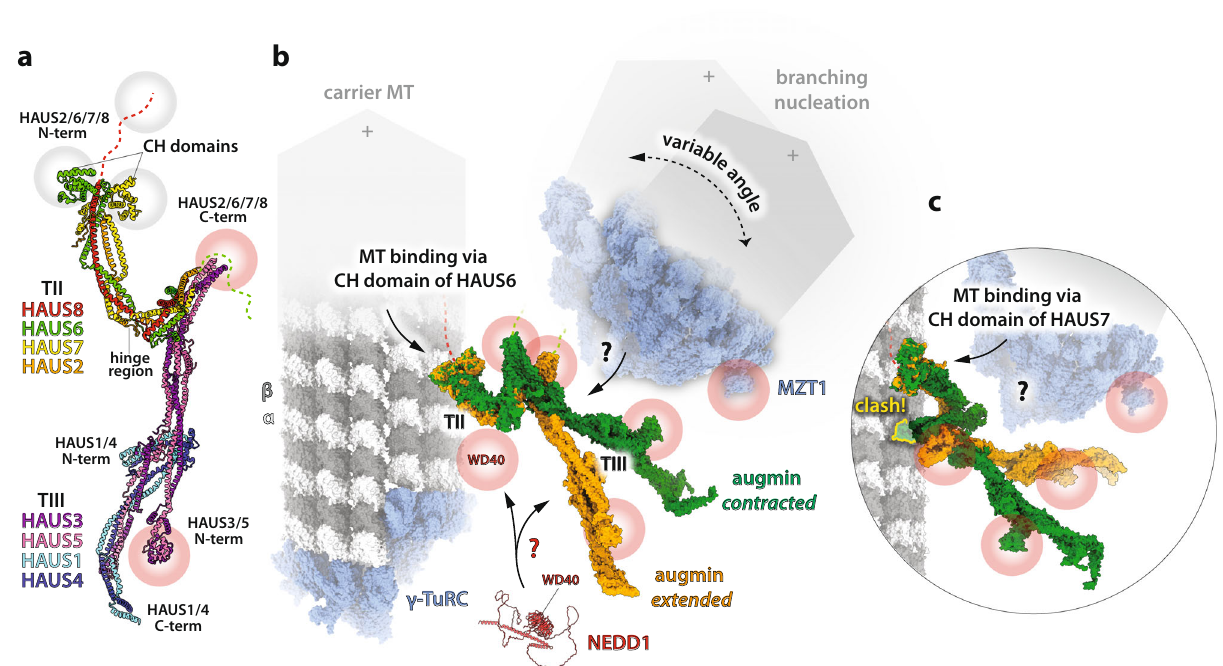
Fig. 1 | Possible scenarios for augmin-mediated MT branching. a Atomic model of the augmin complex ( extended conformation) by Gabel et al. (pdb code: 7SQK). Redandgreendashedlines:disorderedN-andC-terminaldomainsofHAUS8and6, respectively. Grey halos: MT interaction sites. b Depiction of MT branching machinery and its inherent fl exibility based on augmin binding to pre-existing (carrier) MT ( α / β -tubulin dimer, pdb code: 6REV) via the CH domain of HAUS6. Stable MT minus-end is anchored in γ -TuRC (pdb code: 7QJ5), while the dynamic